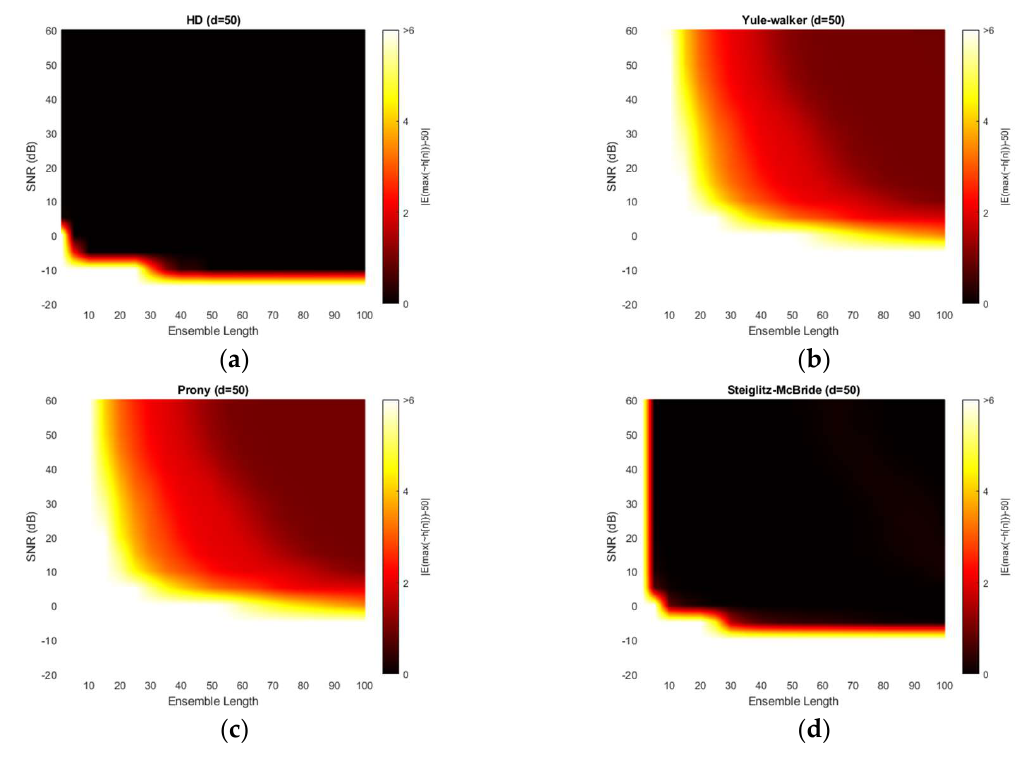
Figure 11. Average estimation error with given ensemble average length & SNR for 50-sample delay: ( a ) non-parametric HD; ( b ) Yule-walker HD; ( c ) Prony HD; ( d ) Steiglitz-McBride HD.